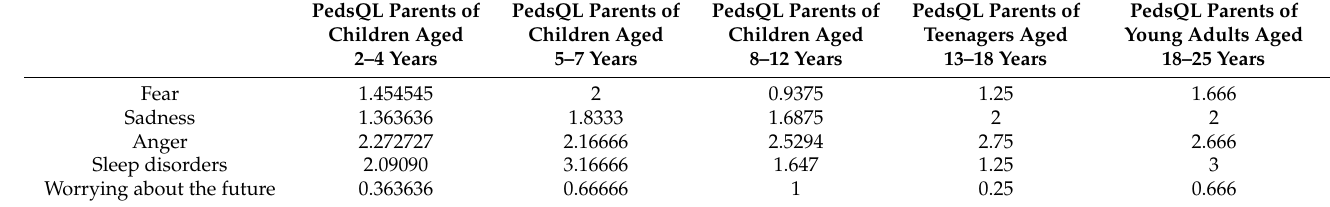
Table 6. Emotional functioning in children with Dravet syndrome.